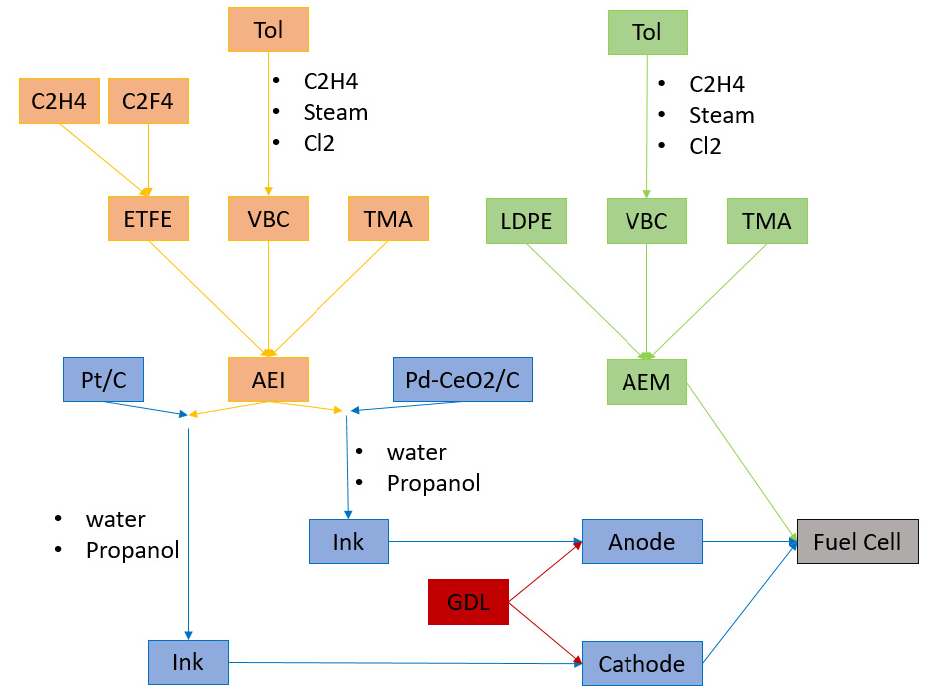
Figure 5. Scenario B: Scheme of the fuel cell preparation, focusing on the anion exchange ionomer (AEI) and anion exchange membrane (AEM). Since ethylene-tetrafluoroethylene (ETFE) and vinyl benzyl chloride (VBC) are not present in the database, a synthesis, based on literature, has been simulated on SimaPRO: ETFE is obtained by polymerization of ethylene and tetrafluoro-ethylene, VBC is synthetized starting from Toluene (Tol).